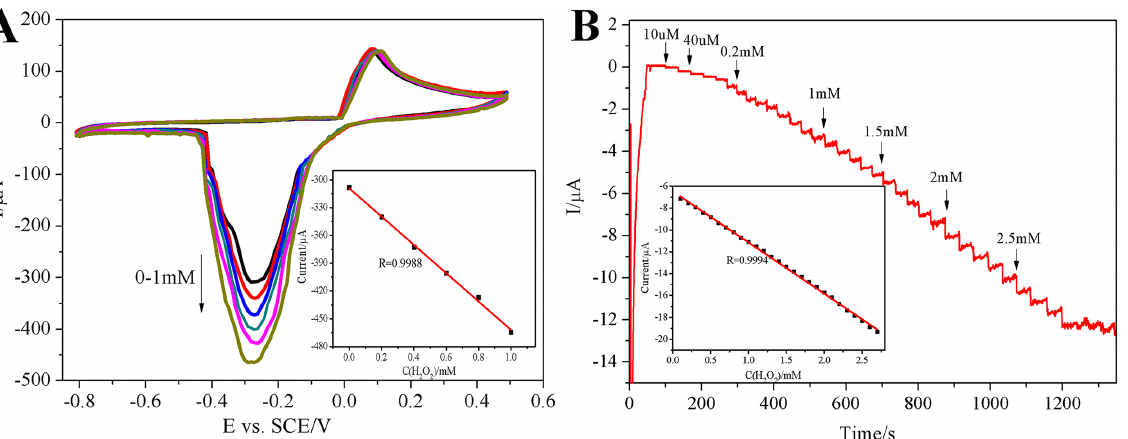
Fig 7. Cyclic voltammograms (A) and amperometric responses (B) of HRP-AuNPs-CESM-GCE electrode with successive addition of H 2 O 2 . (A) 200 μ M H 2 O 2 was added continuously at a scan rate of 50 mV/s (inset: corresponding calibration plot of peak current against different concentrations of H 2 O 2 ). (B) Amperometric responses of HRP-AuNPs – CESM-GCE electrode during successive addition of aliquots of H 2 O 2 (inset: corresponding calibration plot of steady-state currents as a function of different concentrations of H 2 O 2 ) at the applied potential of -0.2 V vs. SCE in 0.1 M PBS solution (pH =